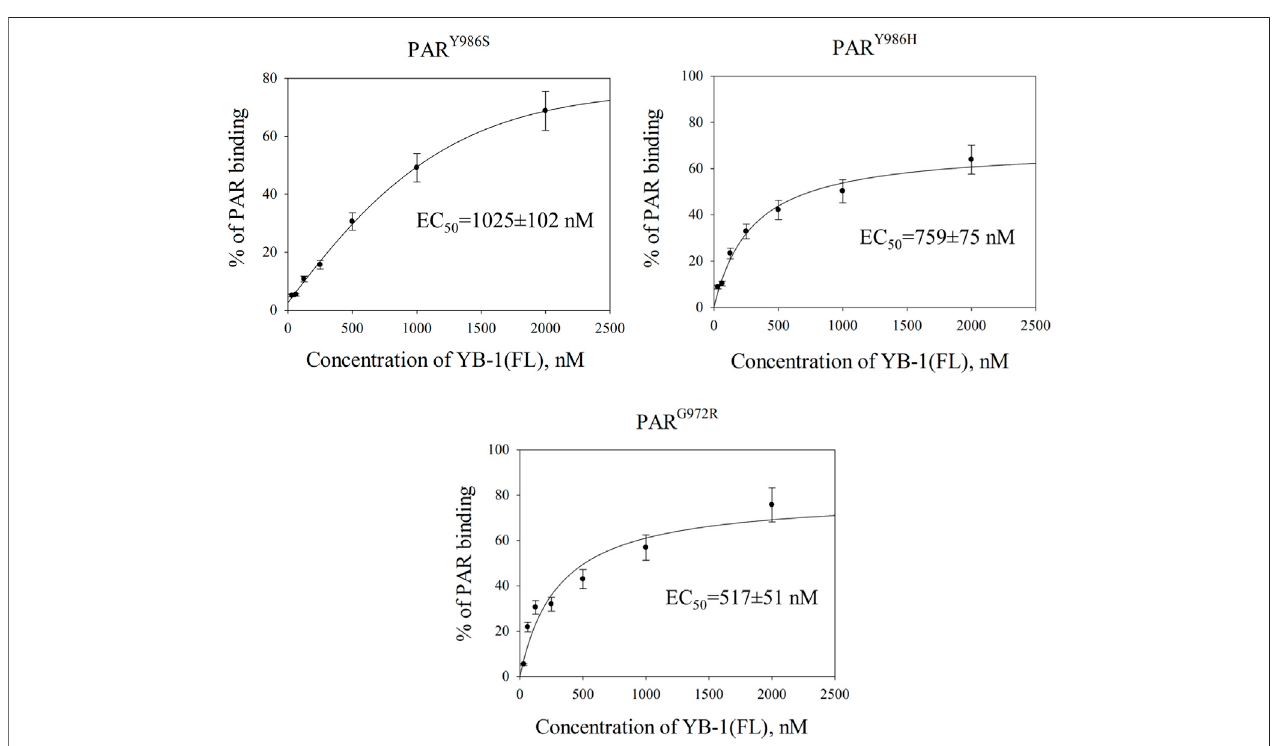
FIGURE 8 | YB-1 af fi nity for protein-free PAR polymers synthesized by PARP1 mutants. Graphs show quanti fi cation of EMSA data ( Supplementary Figure S4 ) and represent themeanvaluesofthree independentexperimentswitherrorbars(±SD).Thebindingparameters(EC50)ofYB-1interactionwithPARwasdetermined as YB-1concentrationresultingin50%substratebinding.EC 50 valuesarethemean(±SD)ofthreeindependentexperiments.Thereactionmixturescontained60 nM[ 32 P]- labeled PAR and YB-1 (FL) at the indicated concentrations.